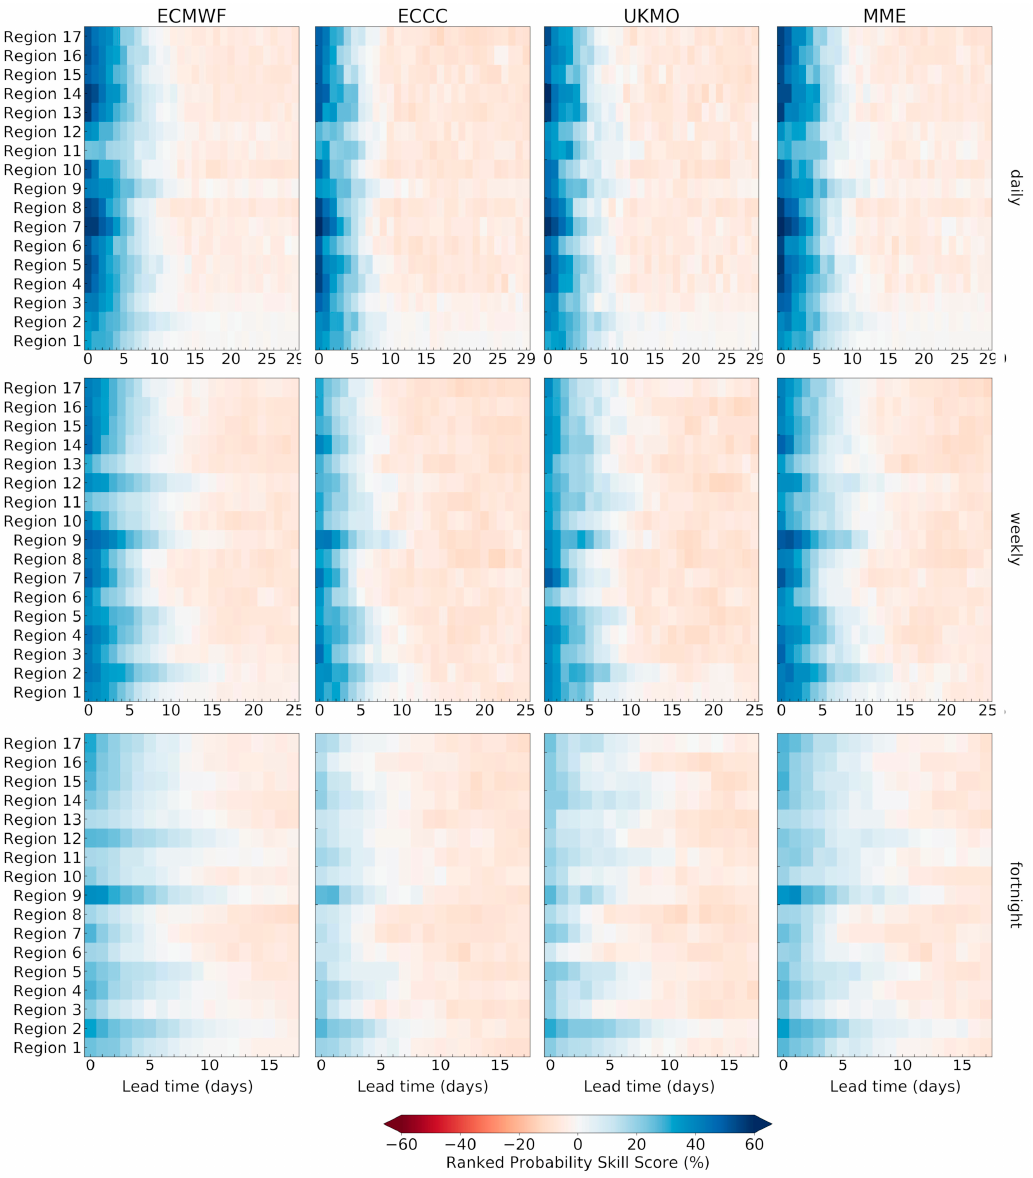
Figure 10. Ranked probability skill score of sub-seasonal precipitation forecasts at different temporal scales (daily, weekly, and fortnight) of the ECMWF model, the ECCC model, the UKMO model, and the MME model for each region during the boreal summer monsoon.